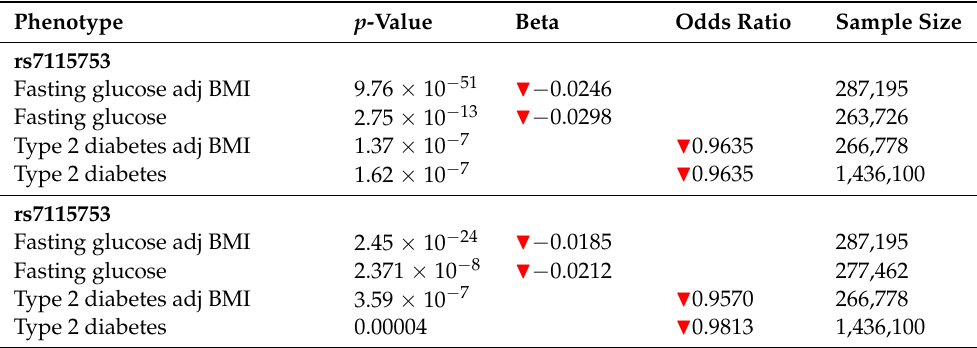
Table 3. Association of top MAPK8IP1 variants across all datasets and traits included in the Type2 Diabetes Knowledge